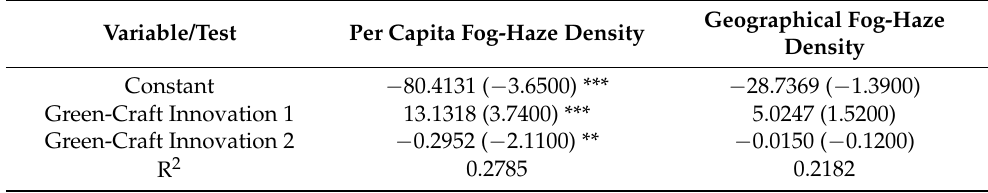
Table 7. Panel regression calculation